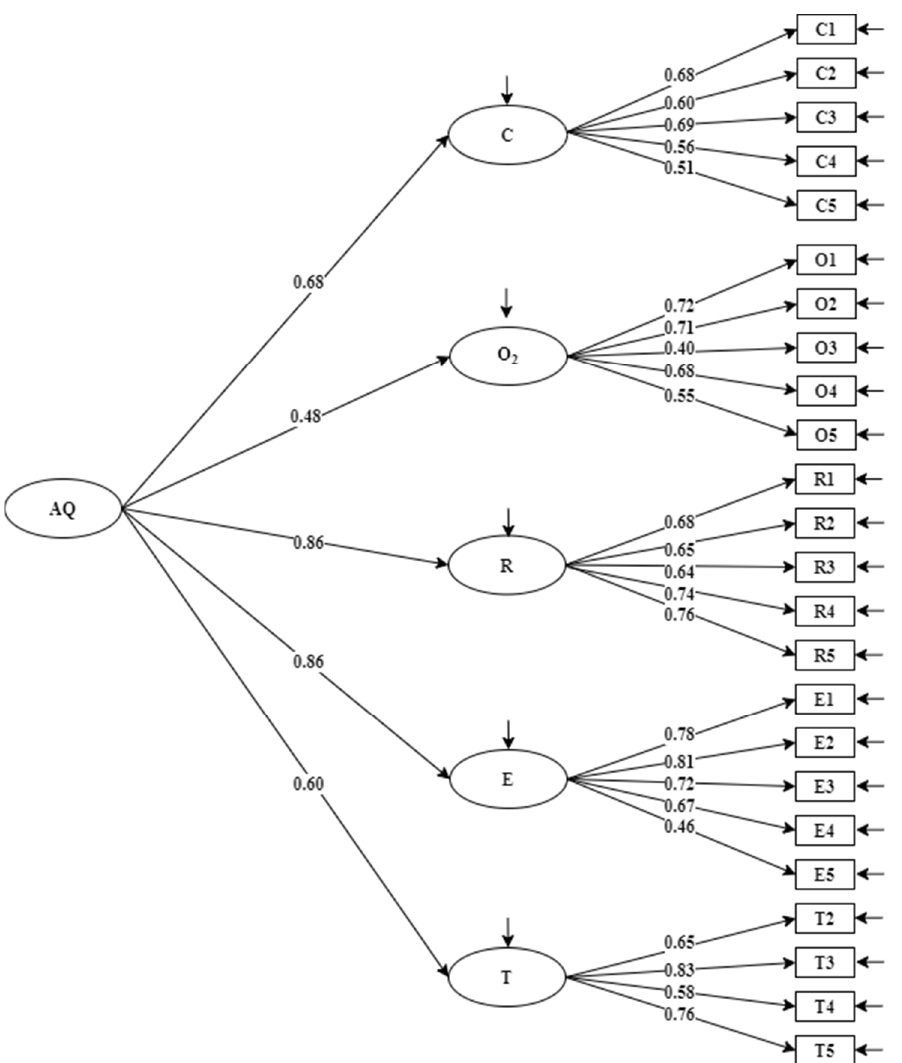
Figure 1. Model 1 with standardized factor loadings on control (C), ownership (Ow), origin (Or), reach (R), endurance (E), transcendence (T), and adversity quotient (AQ) ( n = 242).